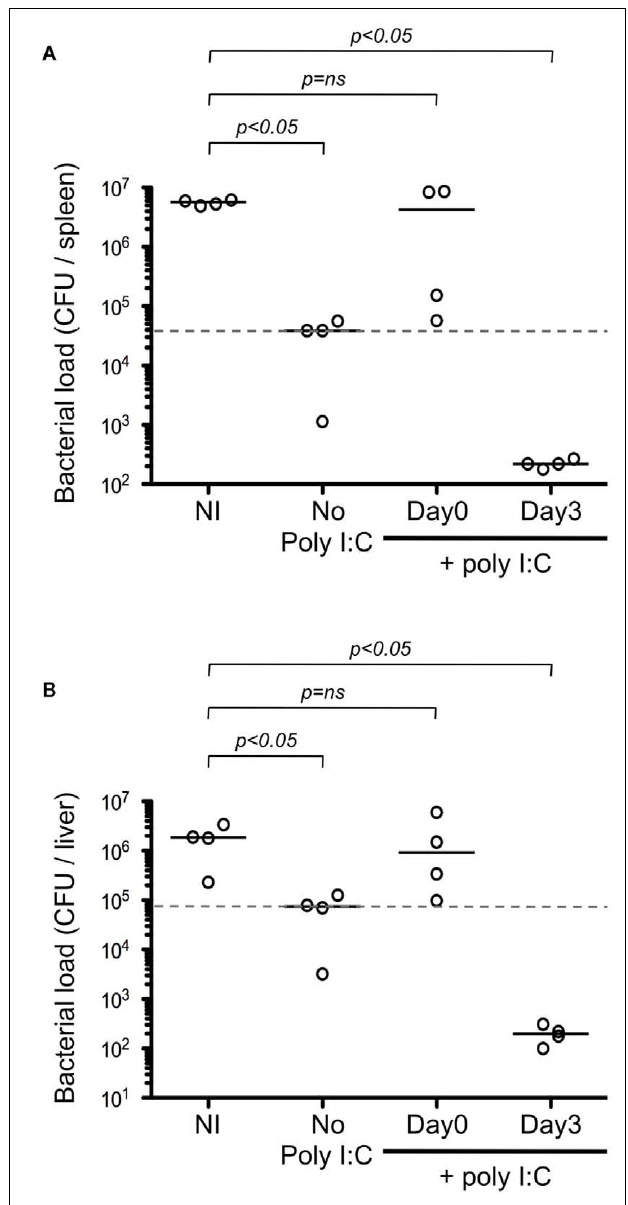
FIGURE 9 |The differential effects of adjuvant impact protection against Listeria . Mice were immunized i.d. with 5 × 10 5 K bm1 mOva splenocytes. Poly I:C was administered either the day of immunization or 3days later. On day 9 post-immunization, mice were challenged with 5 × 10 5 CFU of Ova-expressing Listeria .Two days later, the spleen (A) and the liver (B) were harvested and bacterial load per organ was determined. NI, non-immunized mice. Dotted lines correspond to median CFU in the absence of poly I:C. Mann–Whitney test p -values were calculated, comparing immunization condition to the NI